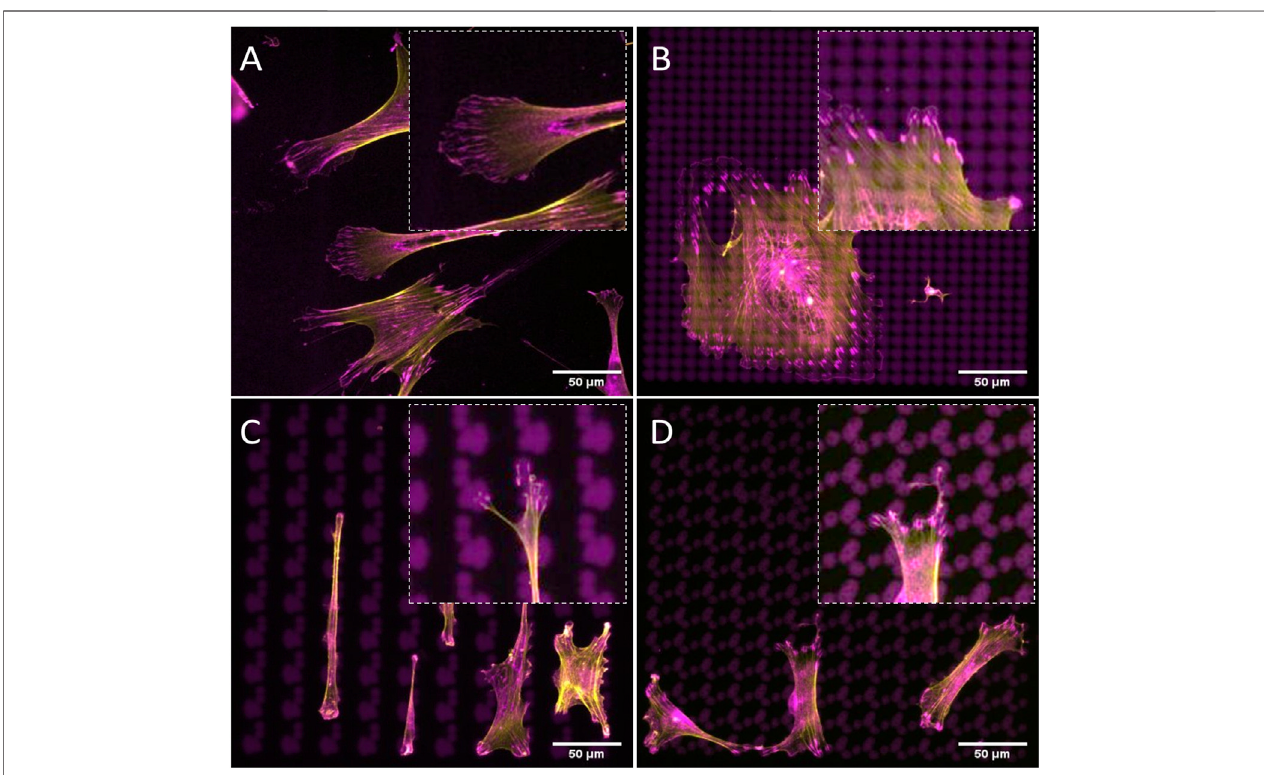
FIGURE5| Cellshapecanbecontrolledbythespatialorganizationofadhesiveislands.hMSCsareculturedsurfacesfullycoveredwith (A) continuouslawnofRGD peptides or (B – D) 2D micropatterns for 4 h and stained with phalloidin to visualize F-actin (yellow) and paxillin (magenta). Adhesive islands are presented in magenta. Scale bars represent 50